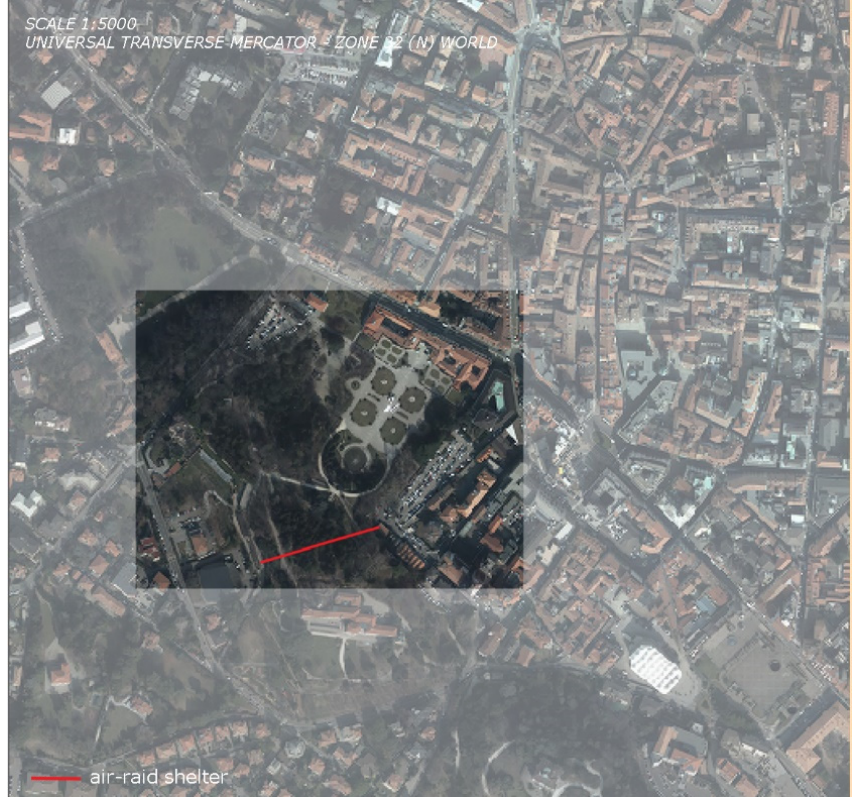
Figure 2. View of the Estensi Gardens. The red line represents the location of the air-raid shelter beneath the hill of the Estensi Gardens (http://maps.google.com, accessed on 29 December